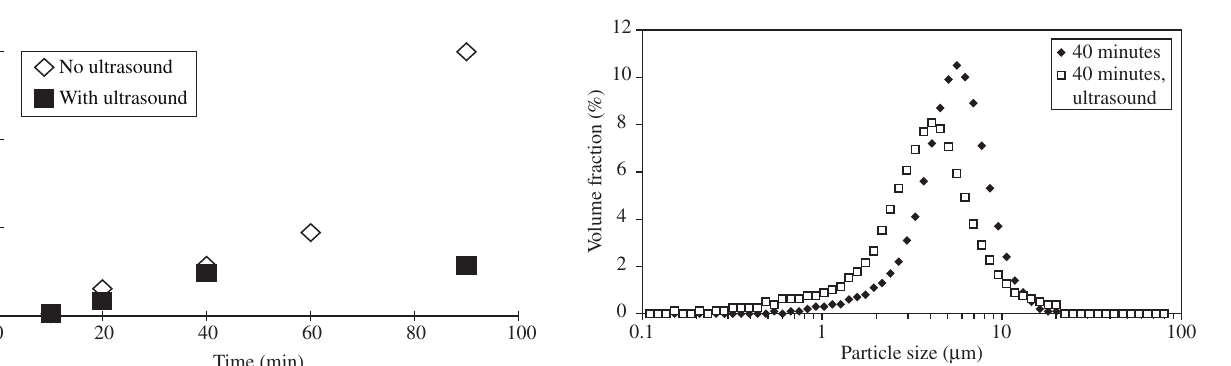
Figure 4. PSD curves of copper particles produced in Test 11, collected after 40 minutes of reaction time, before and after application of ultrasound (5 minutes).